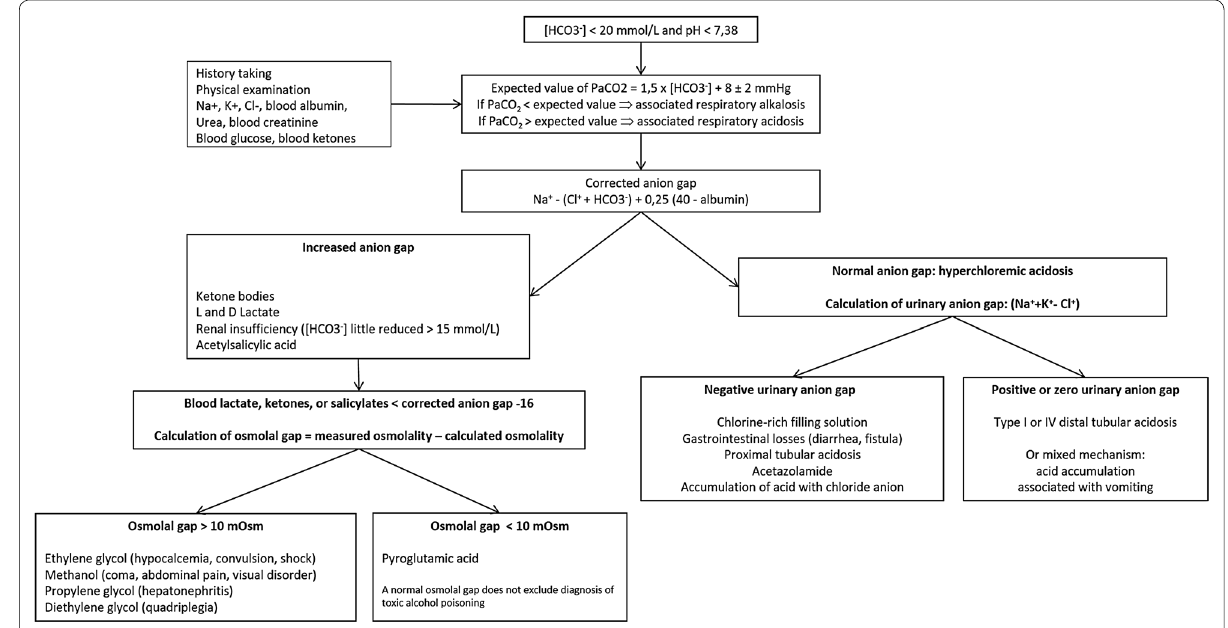
Fig. 1 Algorithm recommended by the experts for etiological diagnosis of metabolic acidemia (EXPERT